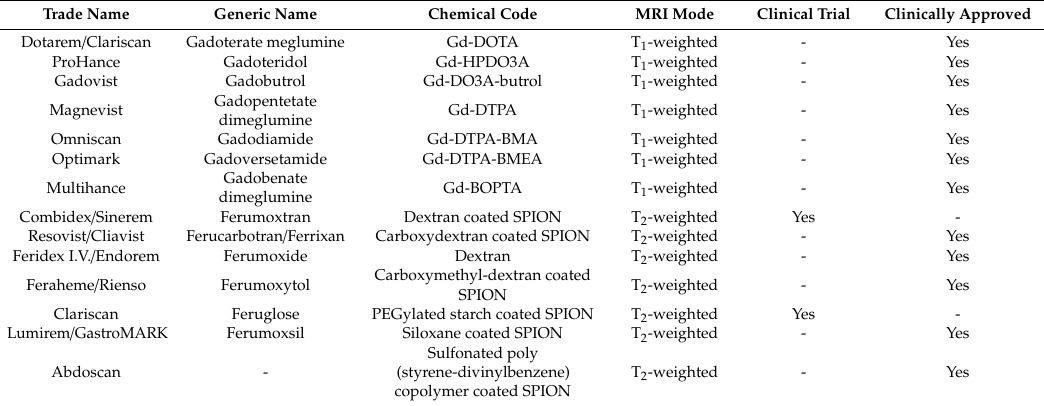
Table 1. Typical magnetic resonance imaging contrast agents (MRCAs) clinically approved or in clinical